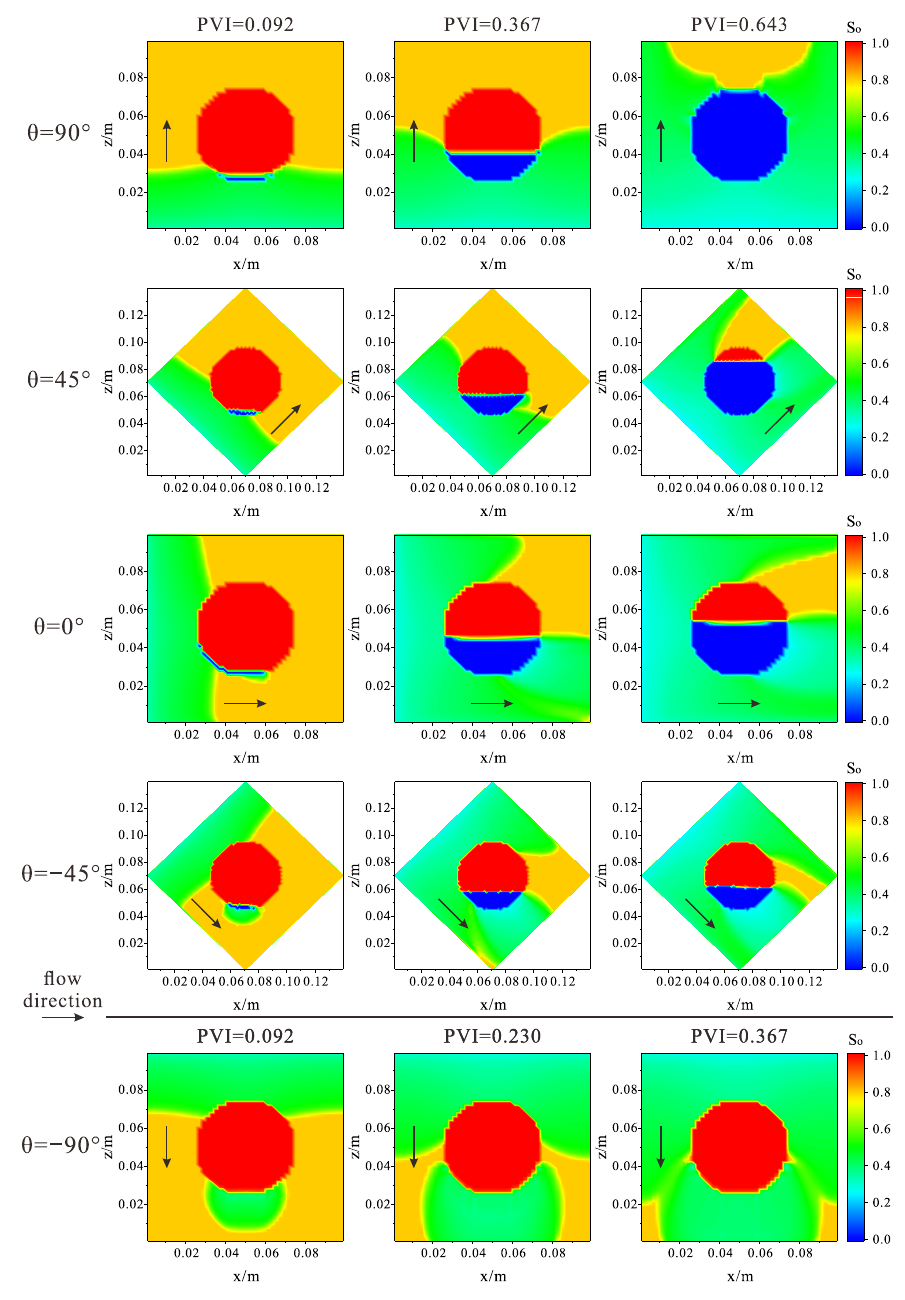
Figure 16. Oil saturation distribution in the single-vug model for five different flow directions.